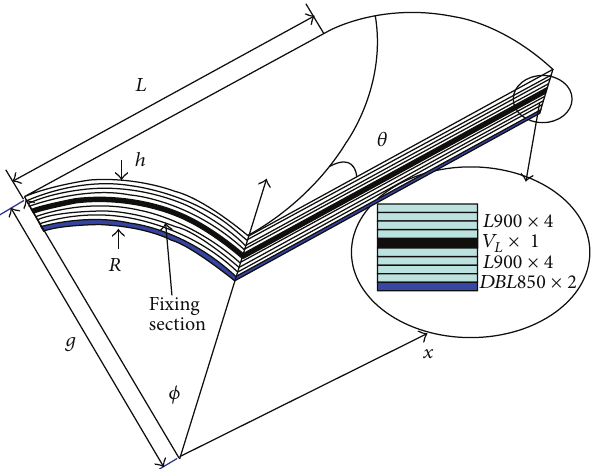
Figure 1: Geometry structure of fiber reinforced cylindrical composite shell with viscoelastic damping layer by considering the lamination